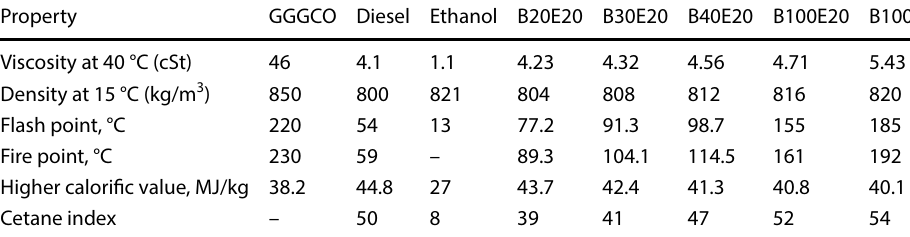
Table 3 Fuel properties of biodiesel–diesel–ethanol